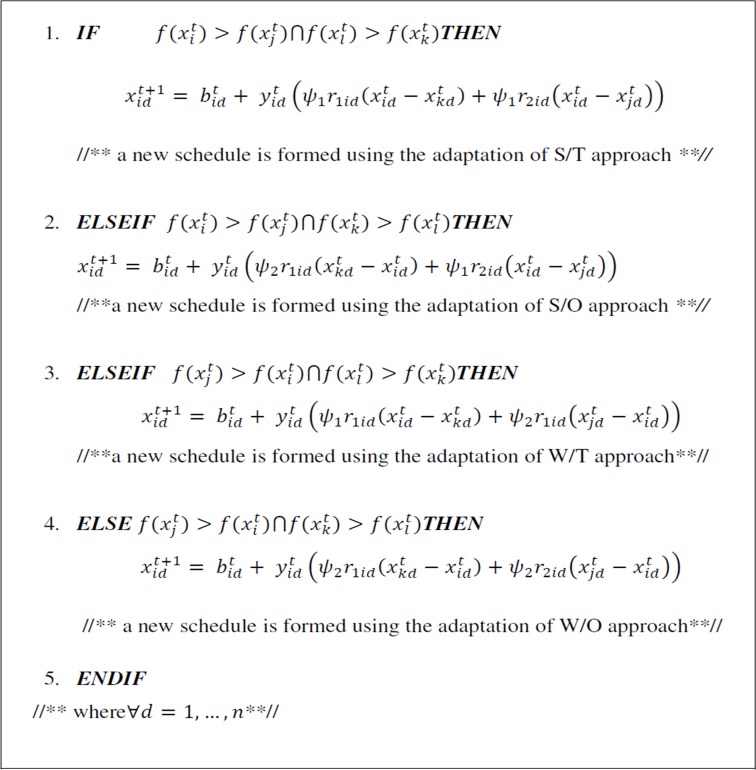
SWOT Pseudo-code.